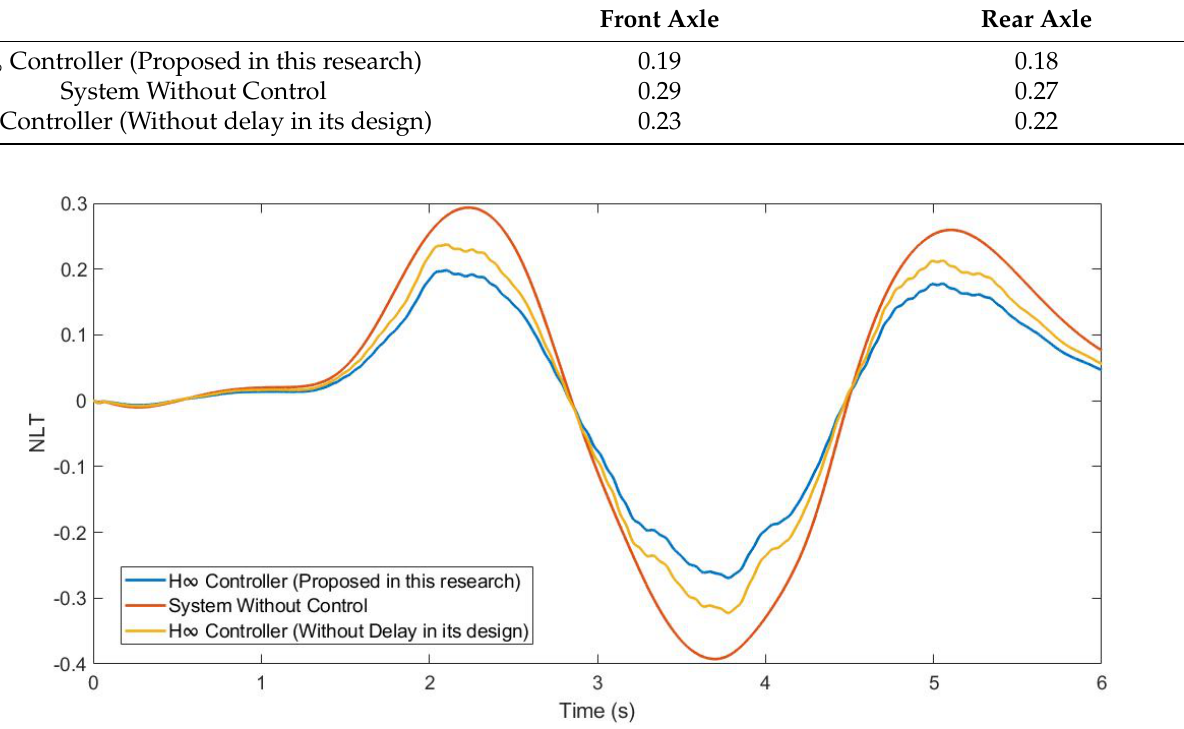
Figure 17. NLT of front axle for test 2: Double lane change at 100 km/h.